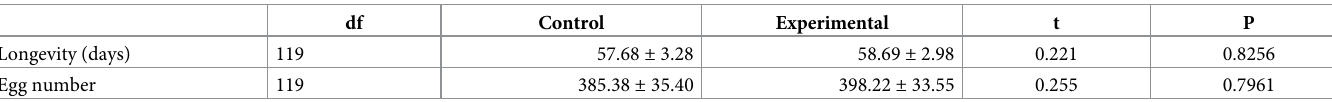
Table 4. Mean female longevity and egg number of control and tested female western corn rootworm from forced flight experiments (Mean ± SE).